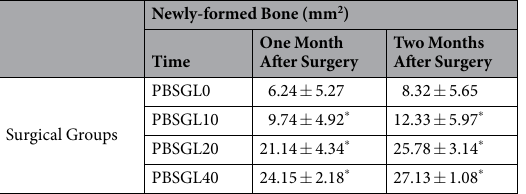
Table 4. The new bone formation in the surgical groups at two time points after surgery (mean ± standard error). (One star denotes a statistically significant difference (P < 0.05) between the control group and the test at each time point. n = 5 animals at each time point. Each animal had 4 calvarial defects and from each defect 6 histological cross-sections were